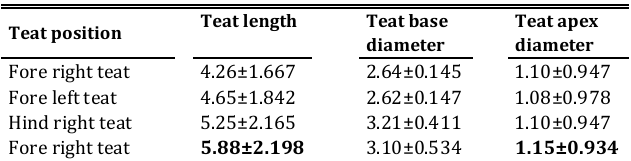
Table 1. The biometric measurements of teats in non-lactating udder of Iraqi cow (cm) (Mean±SD)